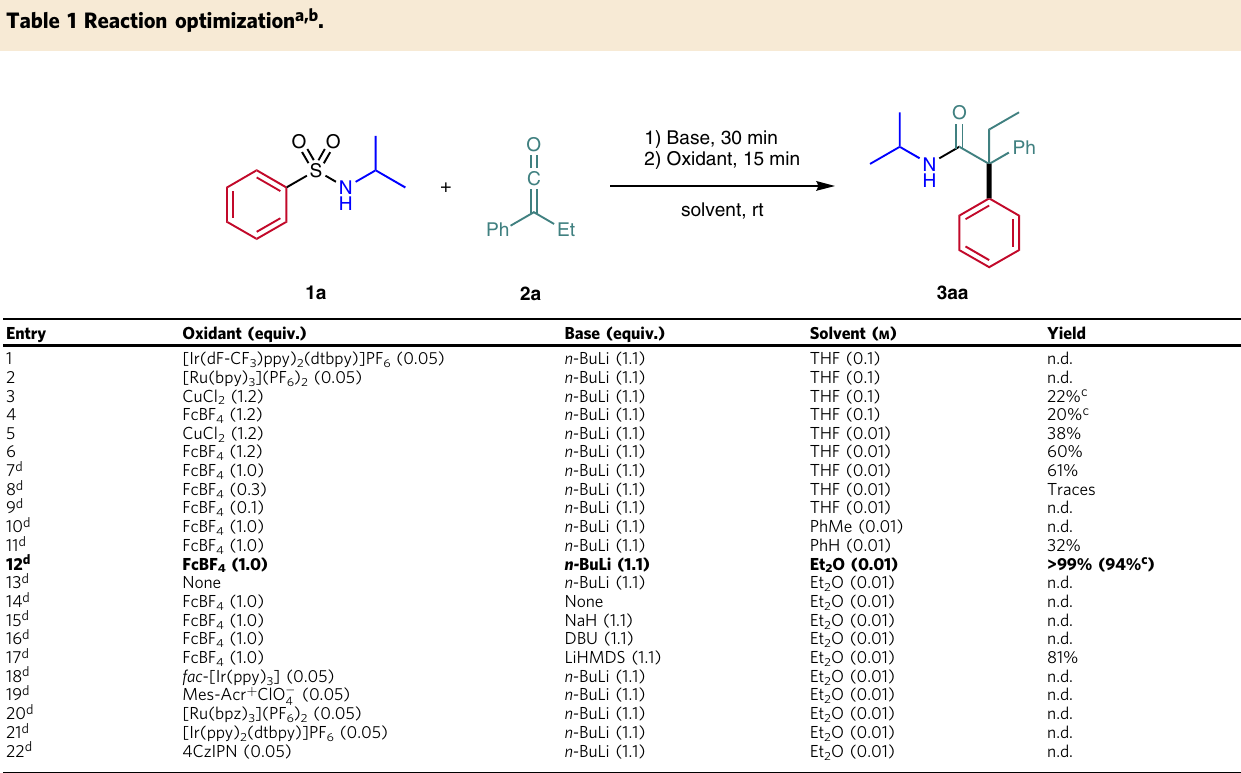
Table 1 Reaction optimization a,b